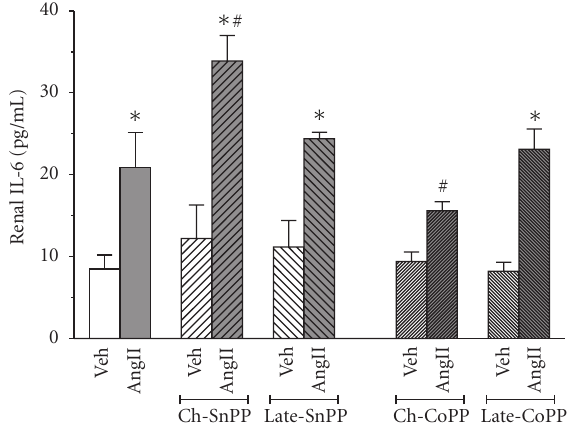
Figure 5: E ff ect of SP-Ang II and HO modulation on Urinary NGAL excretion was measured in the following groups; Vehicle- (Veh-) treated ( n = 6), SP-AngII-treated ( n = 6), chronic-SnPP- (Ch-SnPP-) treated ( n = 6), SP-AngII/Ch-SnPP-treated ( n = 6), late-SnPP-treated ( n = 5), SP-AngII/late SnPP-treated ( n = 5), chronic-CoPP- (Ch-CoPP-) treated ( n = 6), SP-AngII/Ch-CoPP– treated ( n = 6), late-CoPP-treated ( n = 5), SP-AngII/Late-CoPP- treated ( n = 6) rats. ∗ P < 0 . 05 versus. control, # P < 0 . 05 versus.